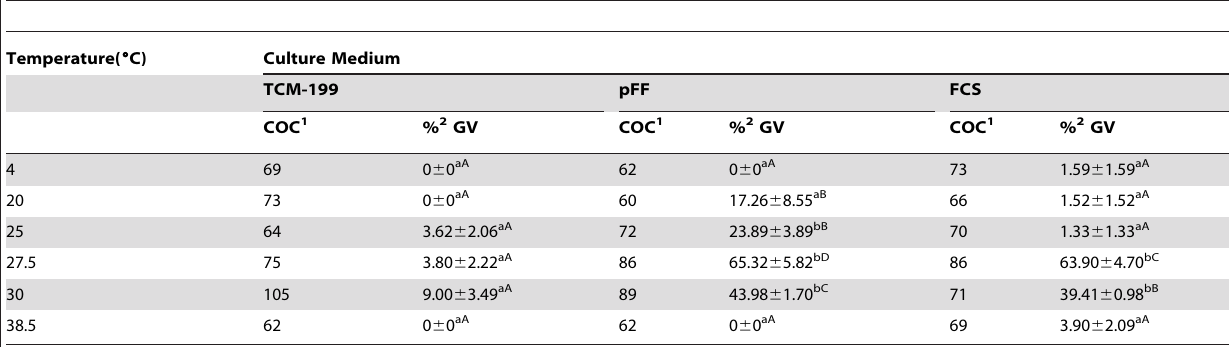
Table 1. Effects of temperatures and media on GVBD inhibition of porcine oocytes after preservation for 3 d*.